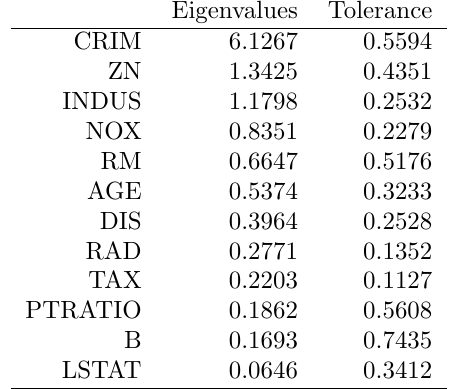
Eigenvalues of the correlation matrix and tolerance of the predictors, Boston Housing